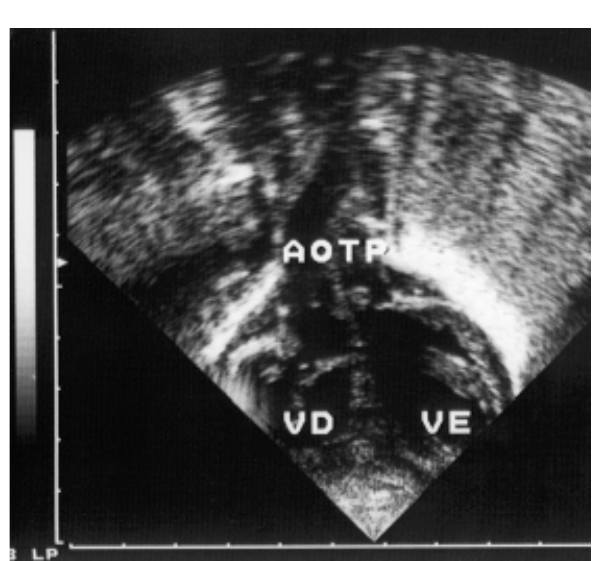
Fig. 3 – Pre-operative echocardiogram demonstrating pulmonary stenosis (A) and interventricular connection (B) with the necessity of resection of the conal septum